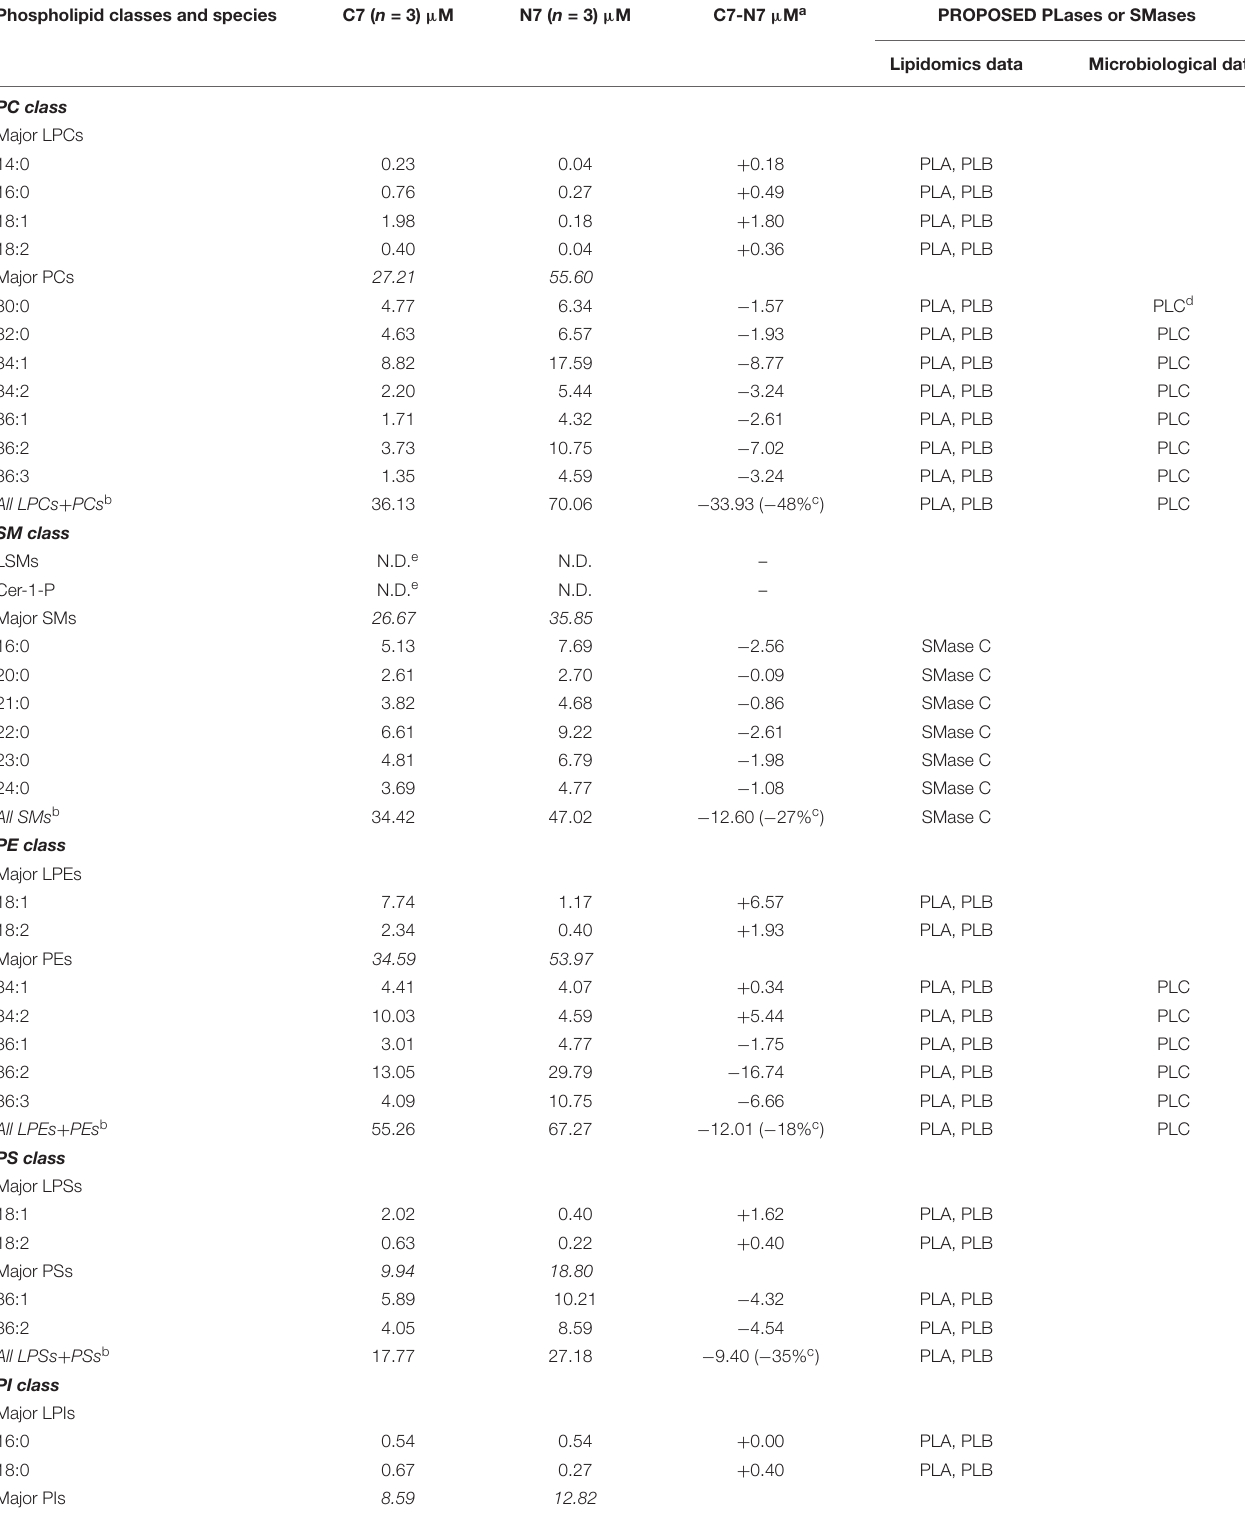
TABLE 2 | Major differences in concentration ( µ M) among phospholipid (PC, SM, PE, PS, PI, and PA) and lysophospholipid (LPC, LPE, LPS, and LPI) species present in bovine raw milk samples (M1, M2, and M3) that were either cold-stored at 6 ◦ C for 7 days (C7) or additionally flushed with N 2 (N7). Phospholipid classes and